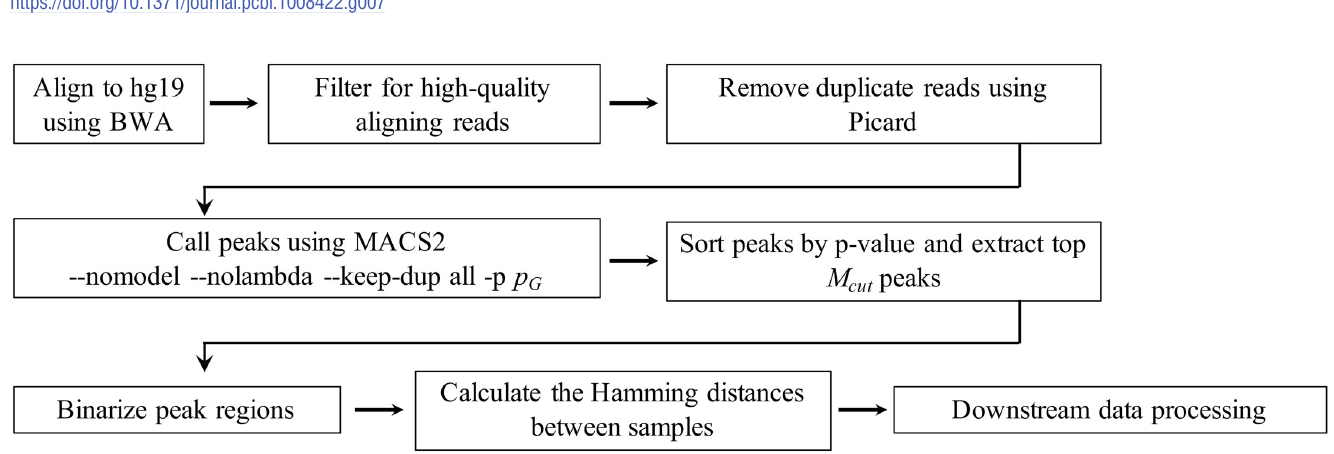
, one leaf, MPP, is not in type HSC, but the three 10